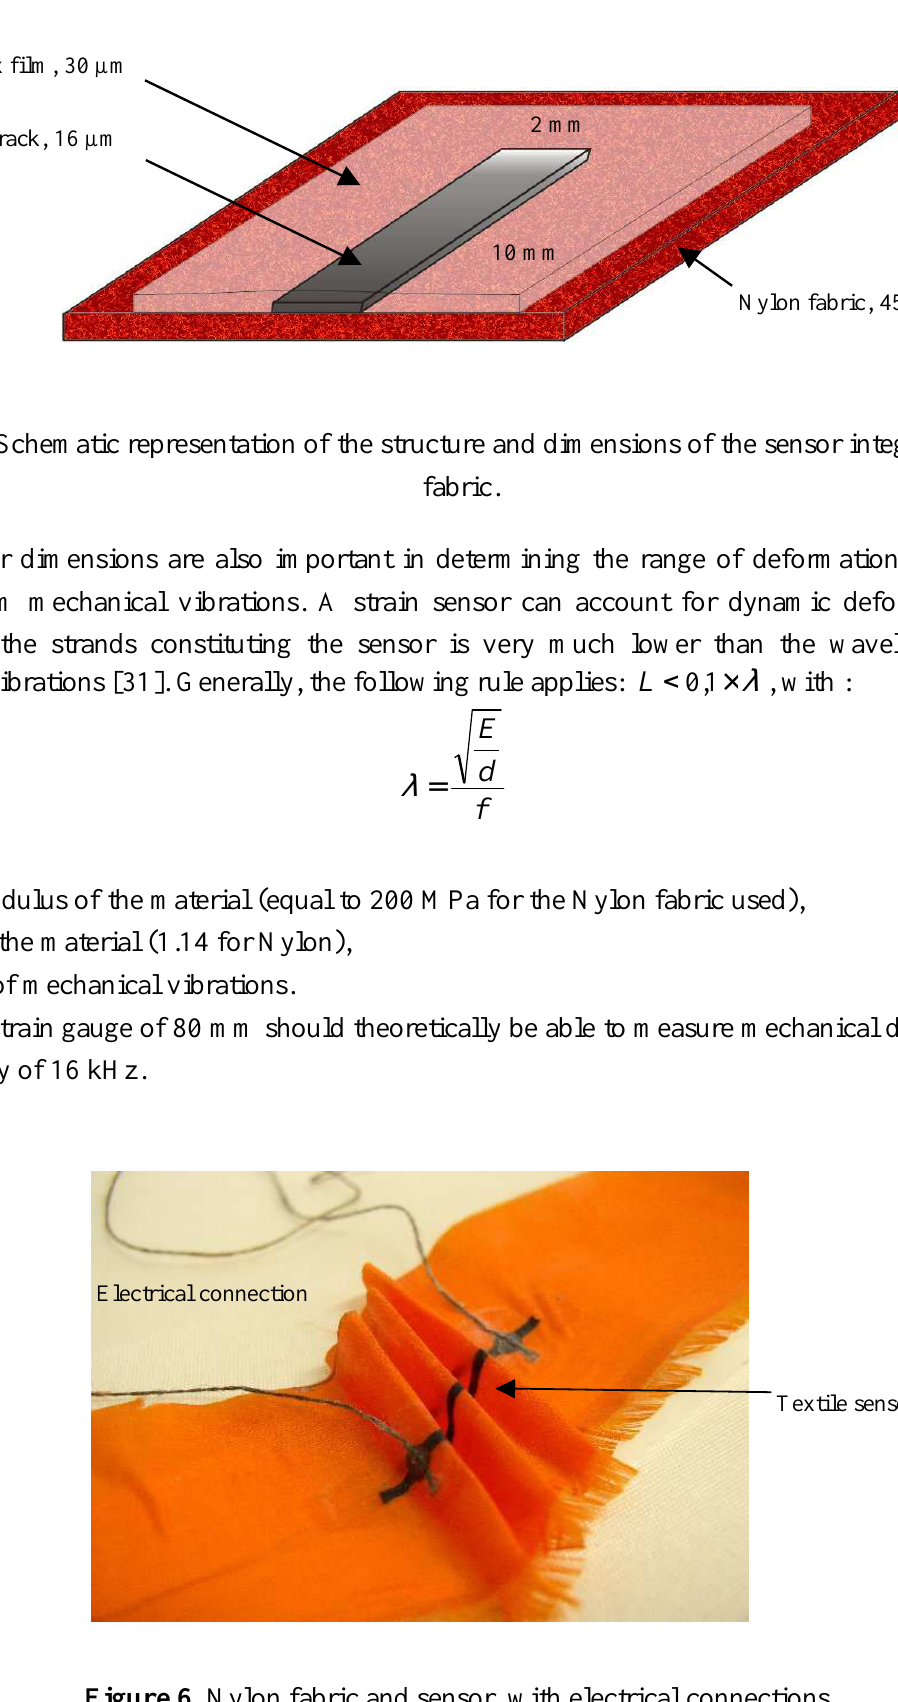
Figure 6. Nylon fabric and sensor, with electrical